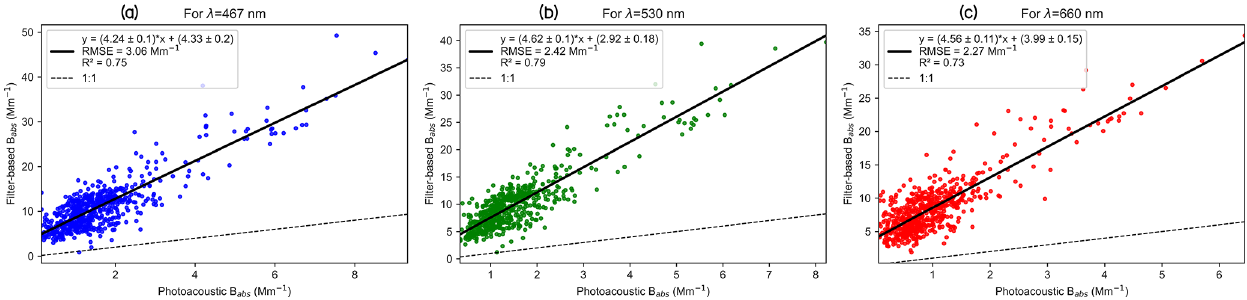
Figure 1. Scatterplot of absorption coefficients from the PSAP and extrapolated PASS measurements corresponding to the (a) 467nm, (b) 530nm, and (c) 660nm wavelengths at the SGP